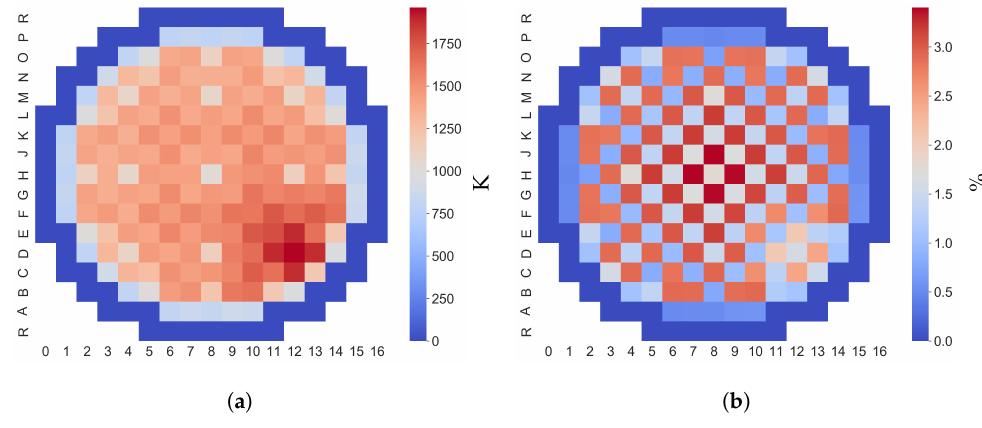
Figure 26. Radial profile of T ave